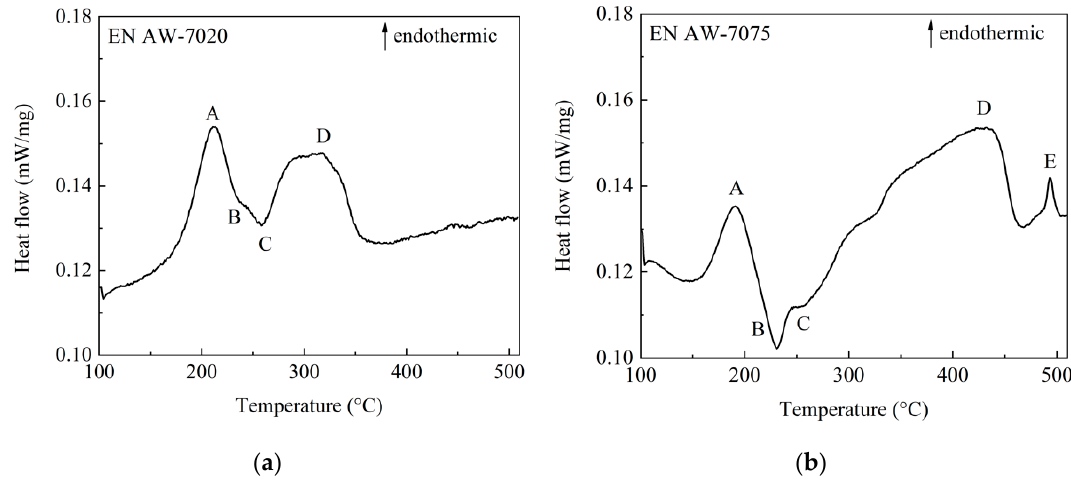
Figure 3. Differential scanning calorimetry (DSC) heating curves for the as-received alloys, ( a ) EN AW-7020 and ( b ) EN AW-7075, at a heating rate of 10 K/min.